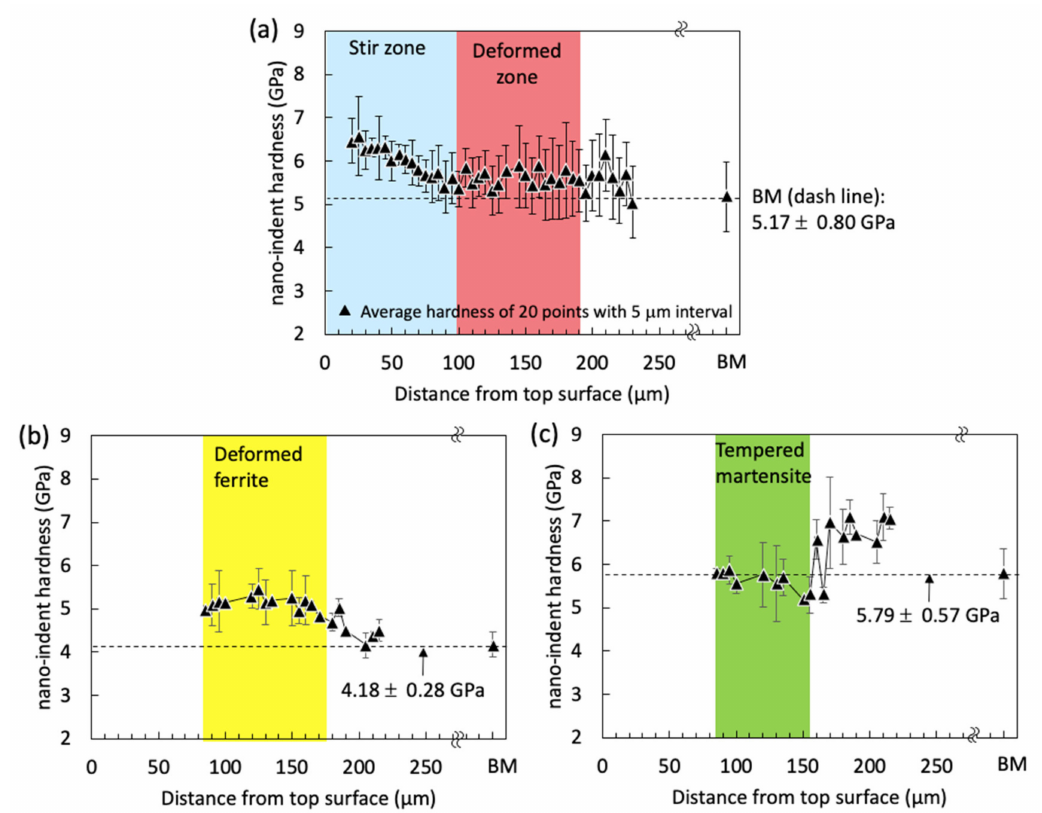
Figure 18. Nano-hardness distribution through thickness direction from the top surface for sample A: ( a ) nano-hardness profiles showing two distinctive regions (SZ and deformed zone in previous Figure 6a). Each point was the average of 20 measurements with standard deviation; ( b ) ferrite only in Figure 18a; and ( c ) martensite only in Figure 18a. The averaged nano-hardness value for ferrite and martensite in the BM is indicated by dash line in each